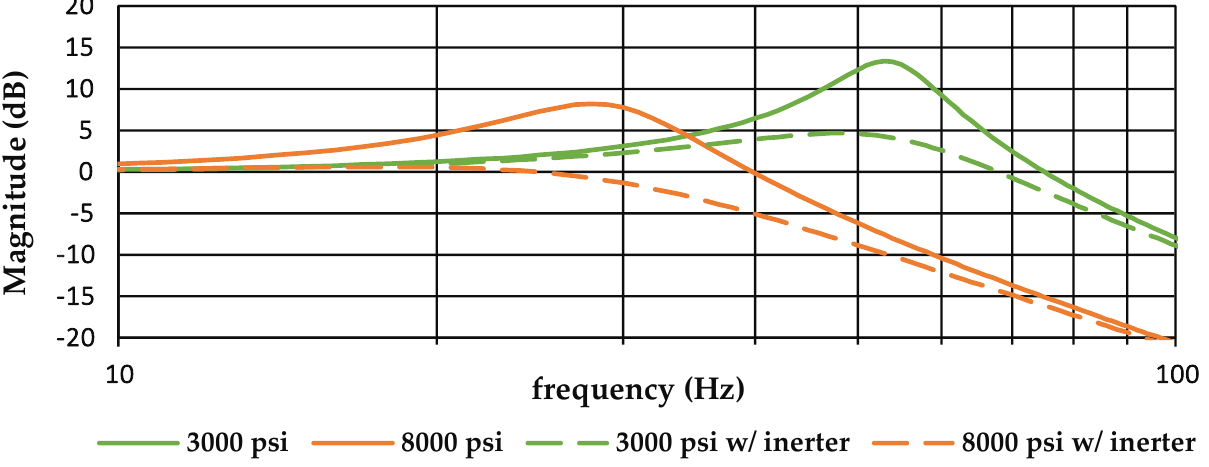
Figure 4. Rotational inerter patent [19].